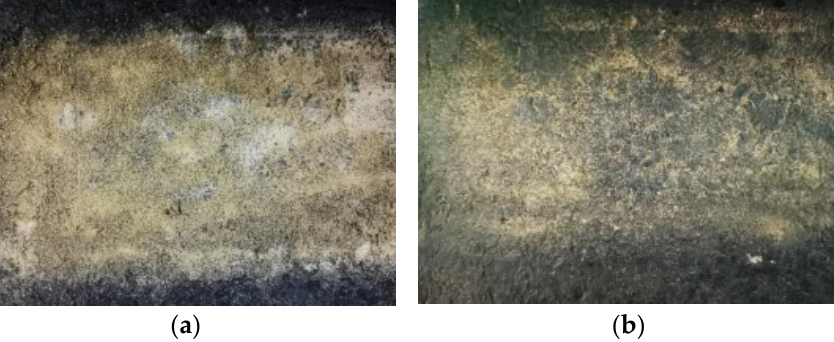
Figure 6. Specimens with a water content of 5% ( a ) and 10% ( b ) respectively after adding aeolian sand.